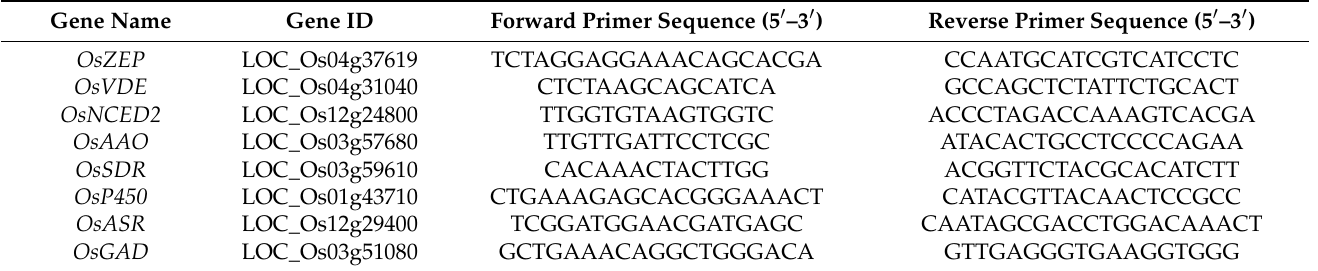
Table 3. Primer pair information of candidate